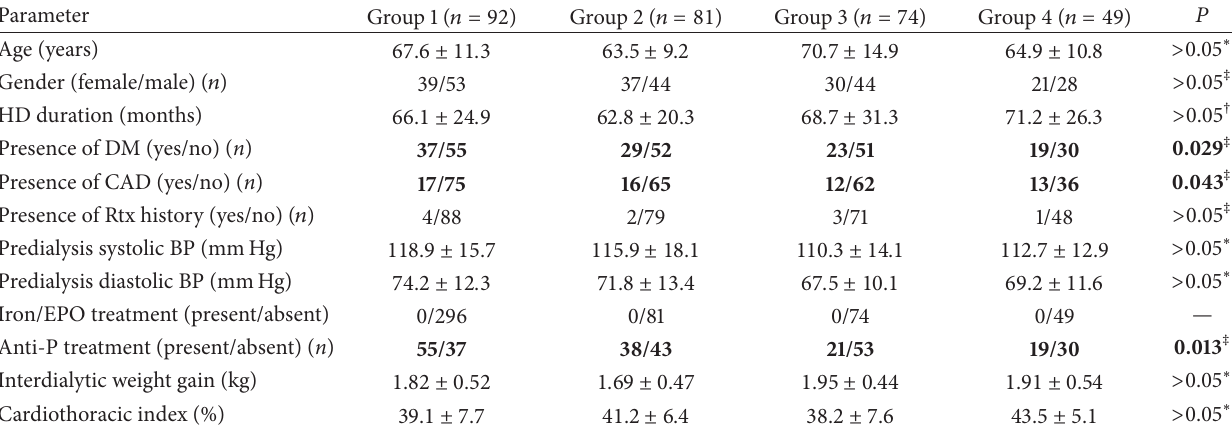
Table 1: The clinical and demographic characteristics of the